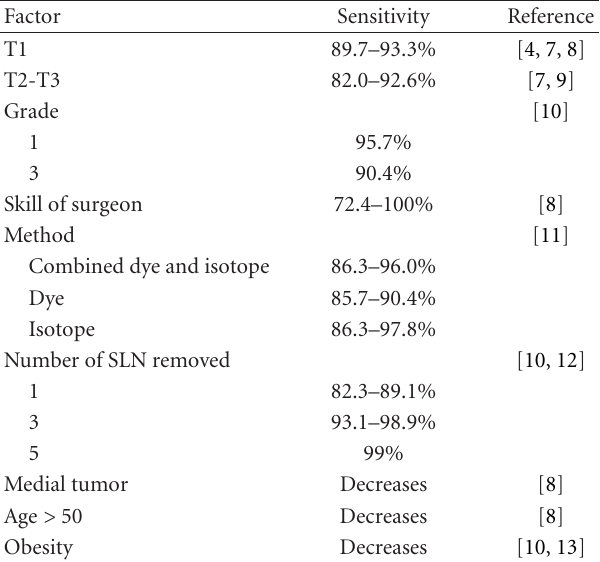
Table 1: Factors influencing the sensitivity of SLN